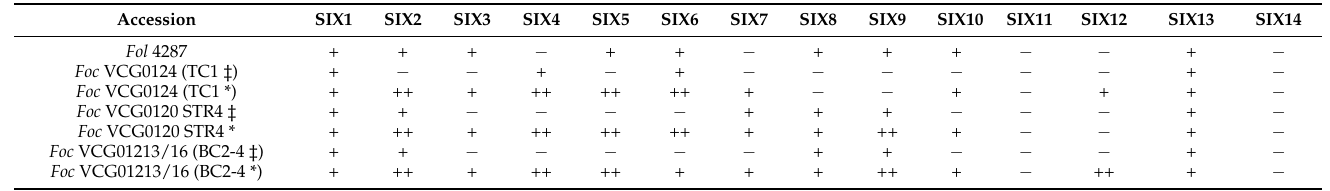
* Represents SIX in the genome of Foc ; where +: present; − ; absent in both PCR and BLAST; ++: presence of SIX other than Foc f. sp. genome where Foc TC1: GCA_011316005.3; Foc STR4: GCA_016802205.1; and Foc BC2-4: GCA_014282265.3. ‡ Results of SIX specific PCR